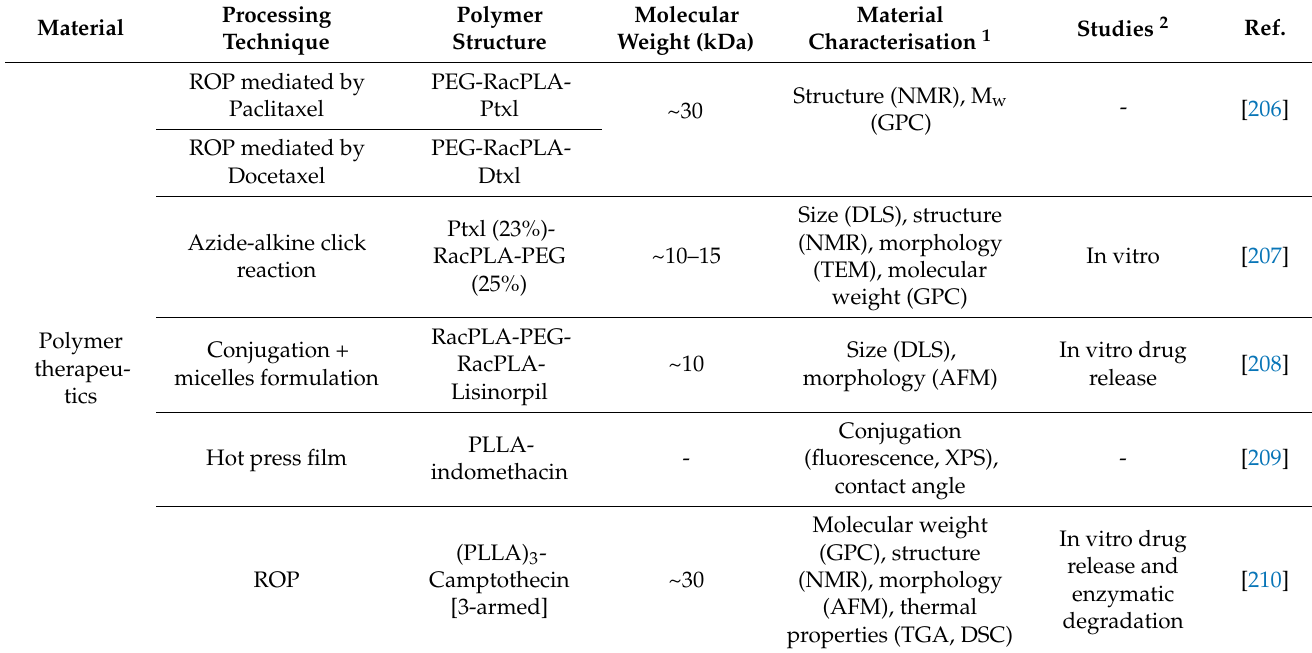
Table 3. Summary of PLA-derivative polymer